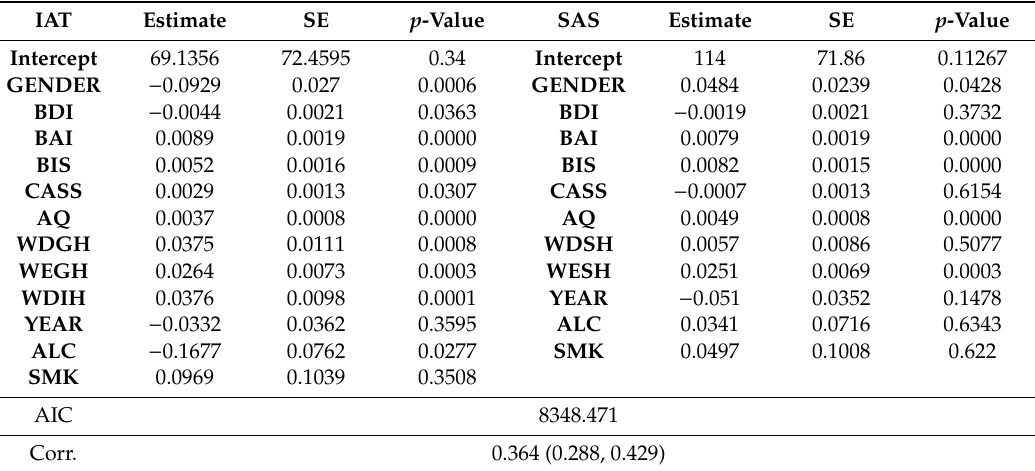
Table 5. Parameter estimates of the t-copula regression